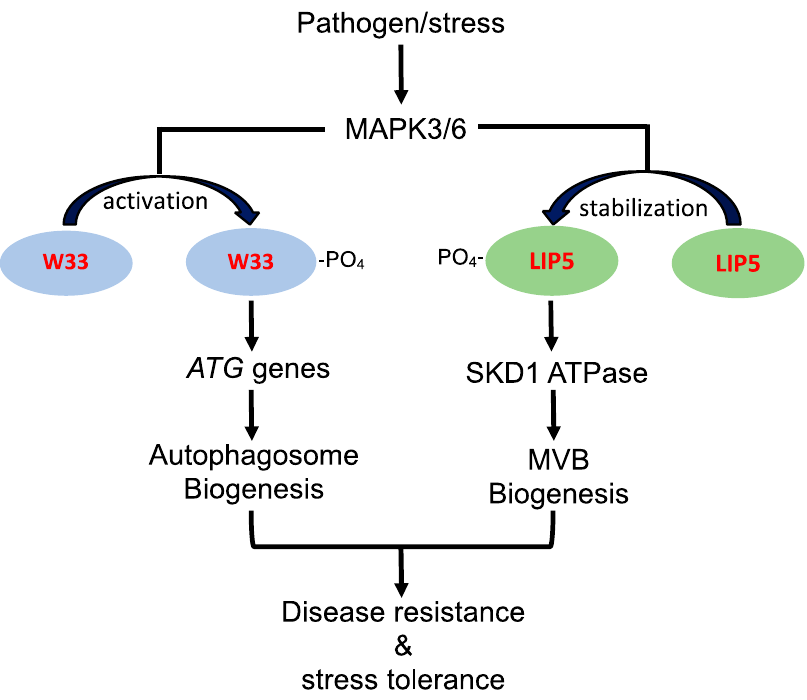
Figure 1. Role of pathogen/stress-responsive MAPK3/6 signaling cascade in stress-induced autophagosome and MVB biogenesis. Pathogen/stress-activated MAPK3 and 6 phosphorylate and activate WRKY33 (W33) transcription factor to activates ATG gene transcription for sustained autophagy induction. Pathogen/stress-activated MAPK3 and 6 also phosphorylate LIP5 to improve its stability for stimulation of SKD1 required for stressed-induced MVB biogenesis. SDK1 is an AAA ATPase that catalyzes the release of the ESCRT-III complex from the membrane during the biogenesis of MVBs. Induced autophagosome and MVB biogenesis promote plant disease resistance and stress